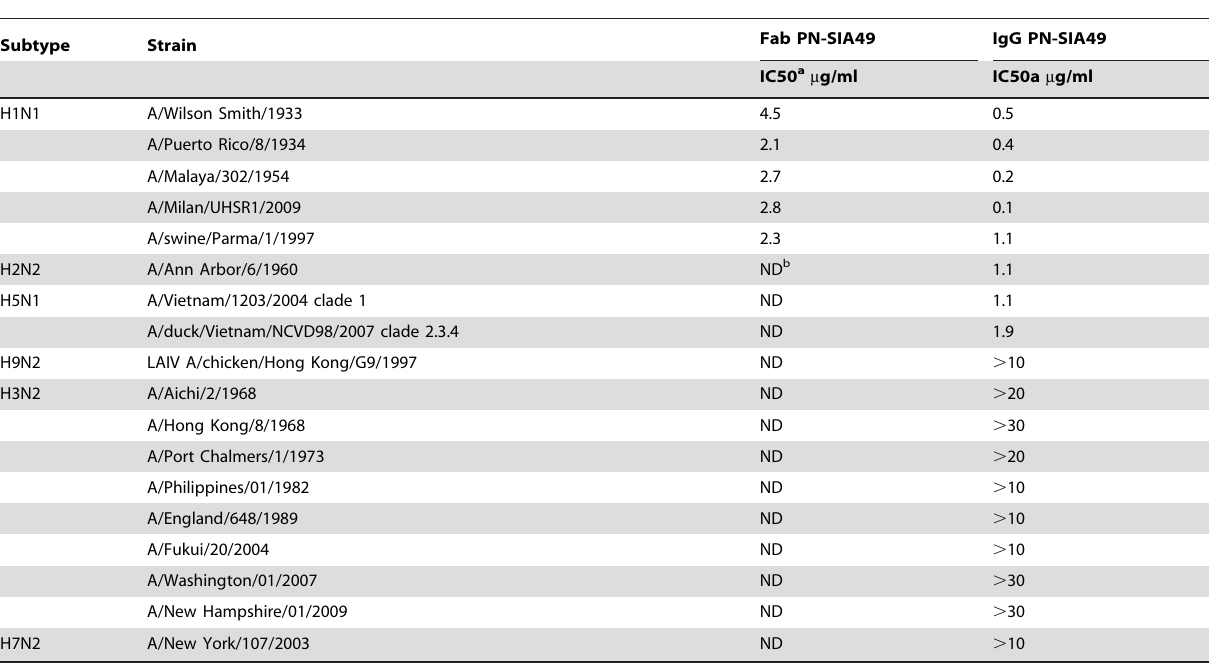
Table 1. PN-SIA49 neutralizing activity against all tested influenza strains.